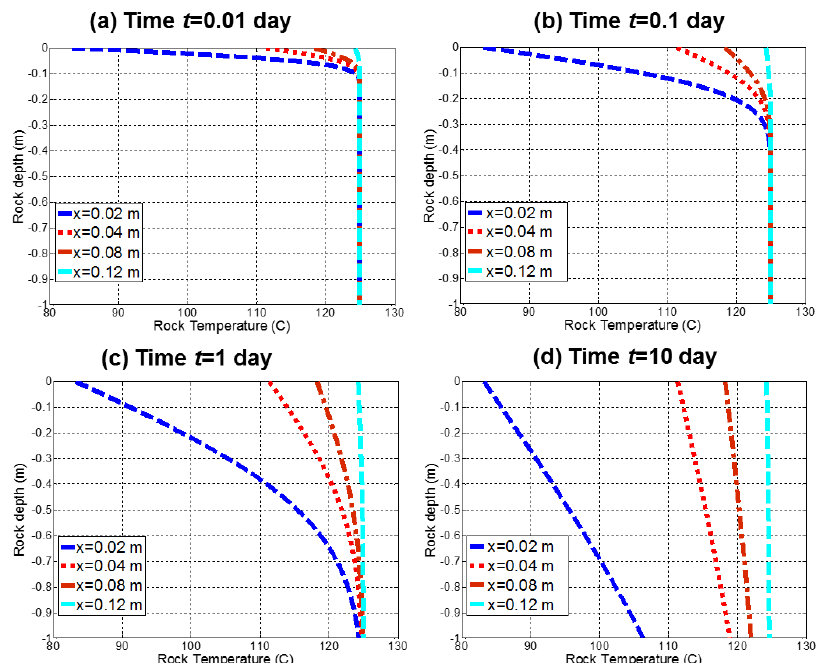
Figure 8. Cooling profile of the host rock at four locations ( x = [0.002, 0.004, 0.008, 0.012] (m)) for different times. ( a ) t = 0.01 day; ( b ) t = 0.1 day; ( c ) t = 1 day; ( d ) t = 10 days. Initial rock temperature is 125 °C. Fracture aperture is 0.005 m. Brine velocity is 0.0001 m/s. The initial fracture wall temperature for time 0 is defined when first fresh injected fluid batch passes by. For example, for x = 0.002 m, the reference time is 0.002/0.0001 = 20 s.